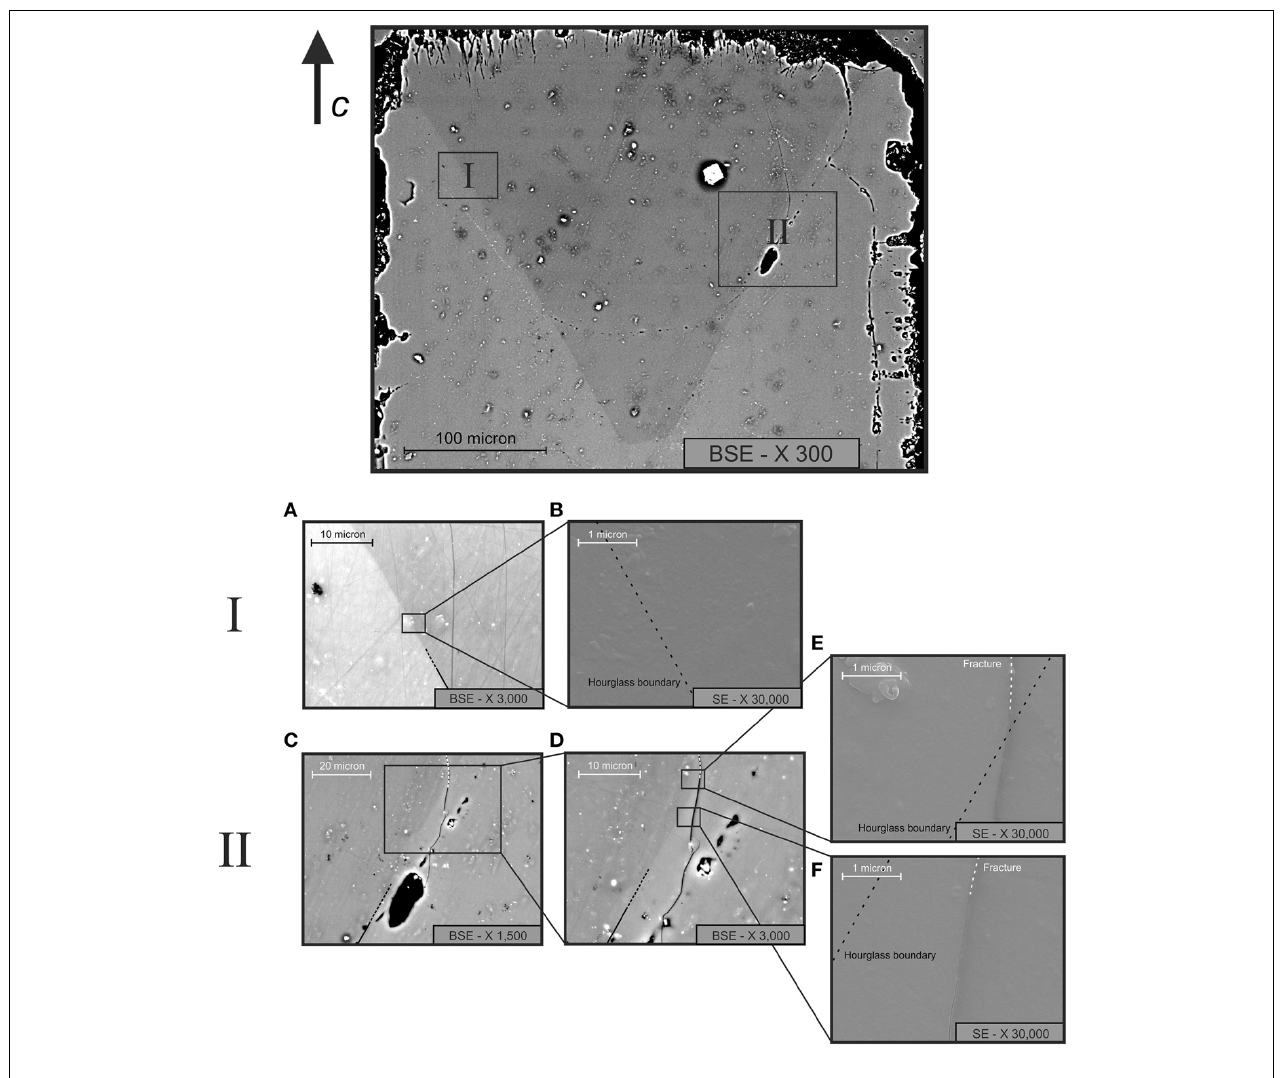
FIGURE 7 | FESEM images of the treated beryl sample across the hourglass boundary, in a fracture-free area (A,B) and in a fractured area (C–F). Note that in ( A,C,D ) BSE (compositional) images of the investigated areas are shown, while